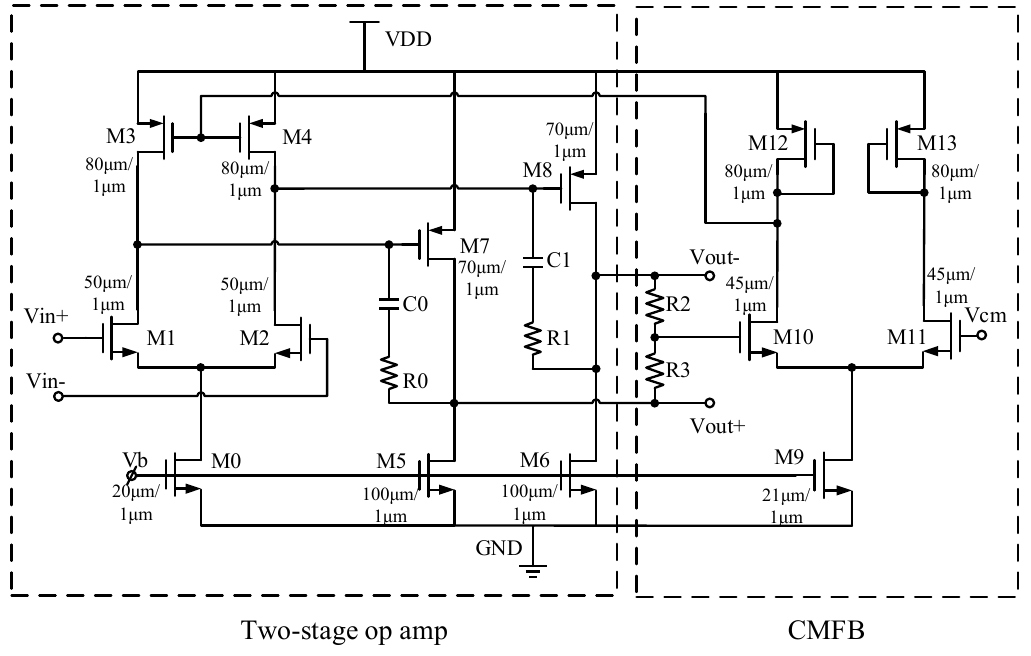
Figure 2. Schematic diagram of the two-stage operational amplifier.